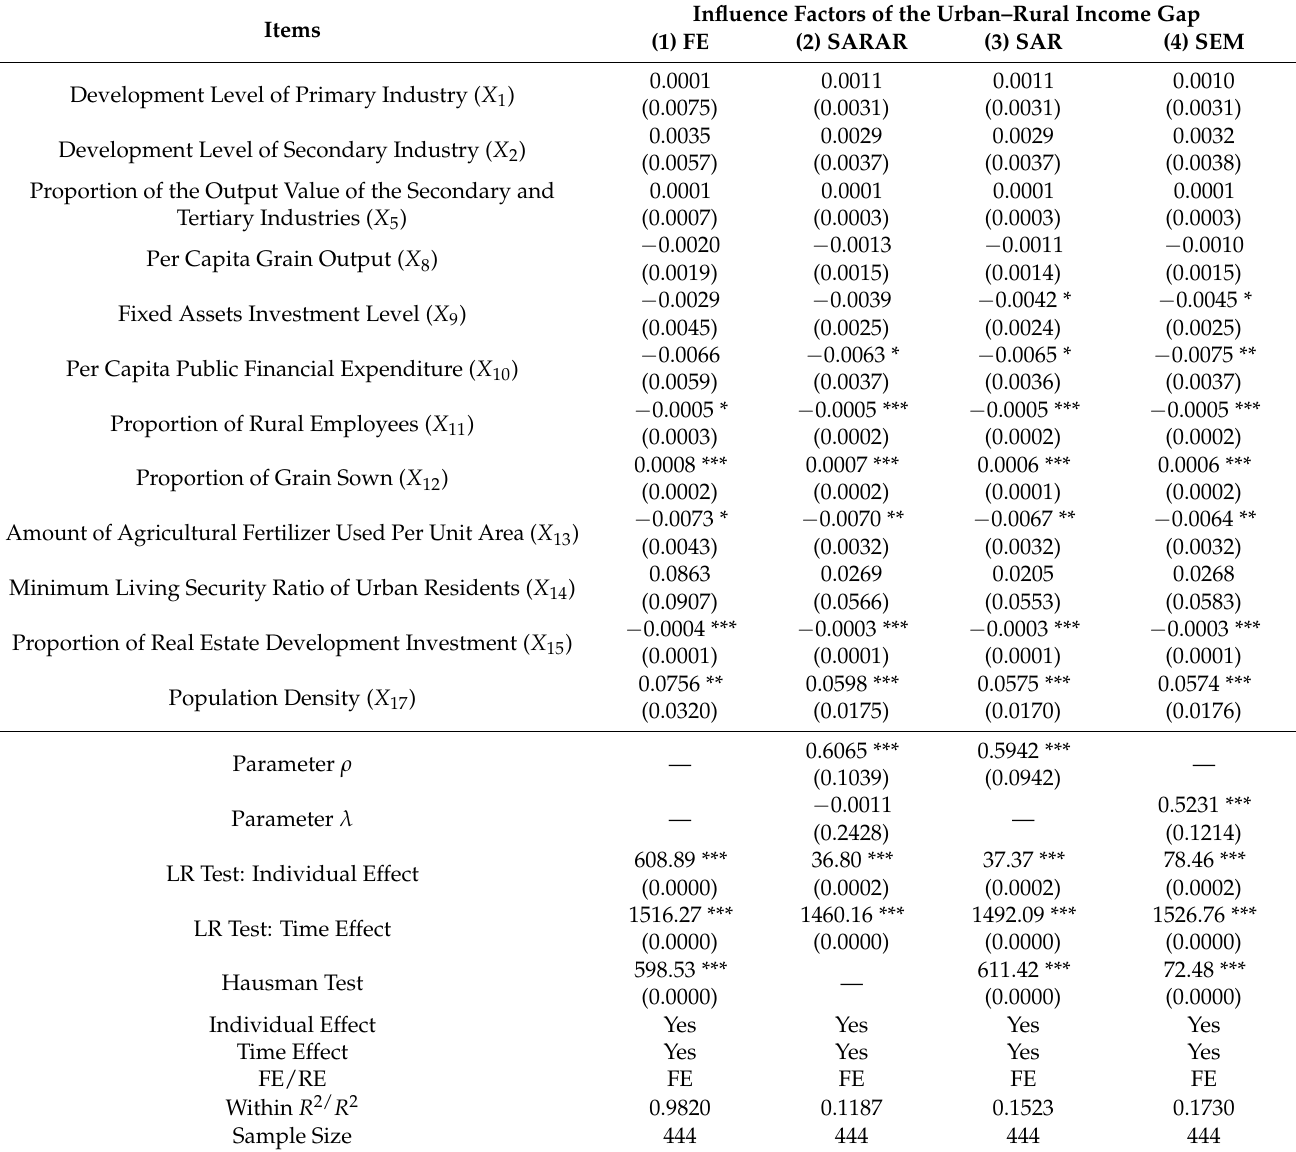
Table 2. Estimation results of the econometric model for the analysis of the influence factors of the urban–rural income